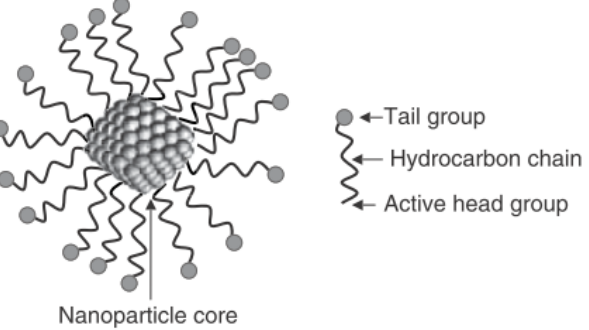
Figure 1. Schematic of a nanoparticle, showing the core and the shell